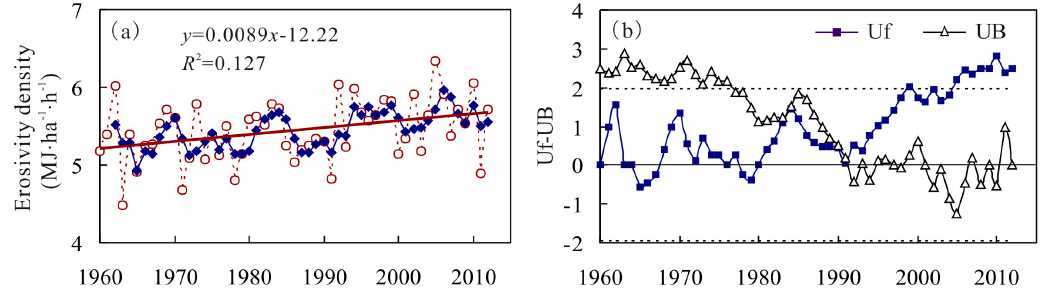
Figure 6. Variation of ( a ) erosivity density and ( b ) the corresponding M-K test trends during the period of 1960–2012 (the line with the solid dots in ( a ) marks the three-year moving average and the horizontal dashed lines in ( b ) represent the critical value of the 0.05 significance level).